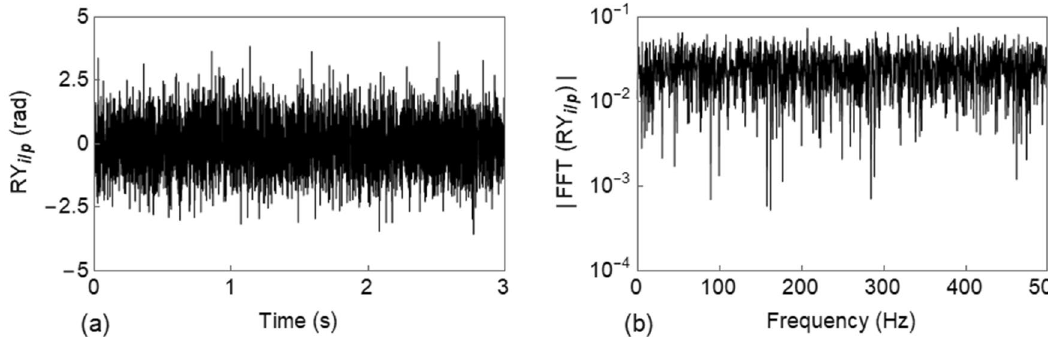
Figure 10. Input rotation ( RY i / p ) applied to the rail: ( a ) time history; and ( b ) FFT.